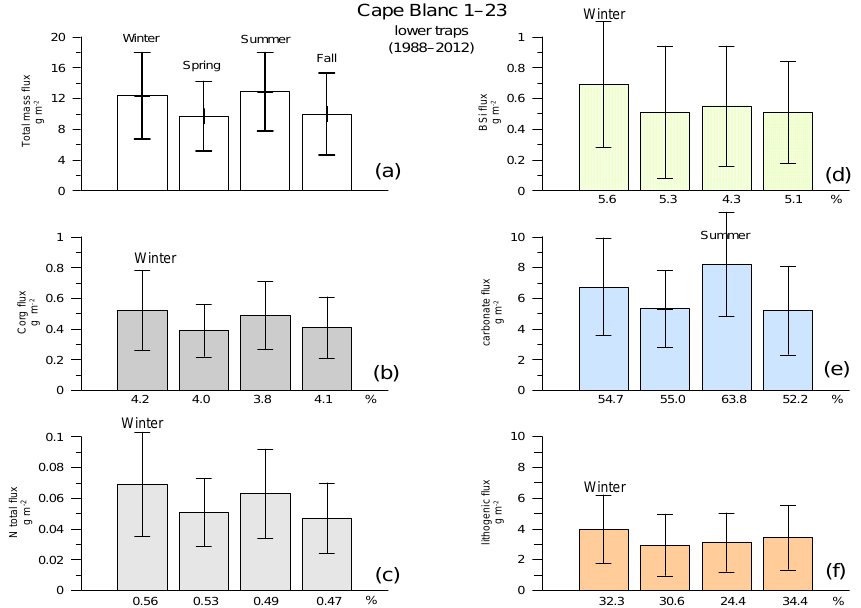
Figure 4. Seasonal means of major bulk fluxes of the lower traps only ( a total, b organic carbon, c nitrogen, d biogenic silica ( = BSi), e carbonate, and f lithogenic = mineral dust) and the respective standard deviations (1SD), which reflect interannual variability. Relative contributions (%) of BSi, organic carbon, nitrogen, carbonate and lithogenic materials to total mass in the respective seasons are indicated by numbers below the bars.